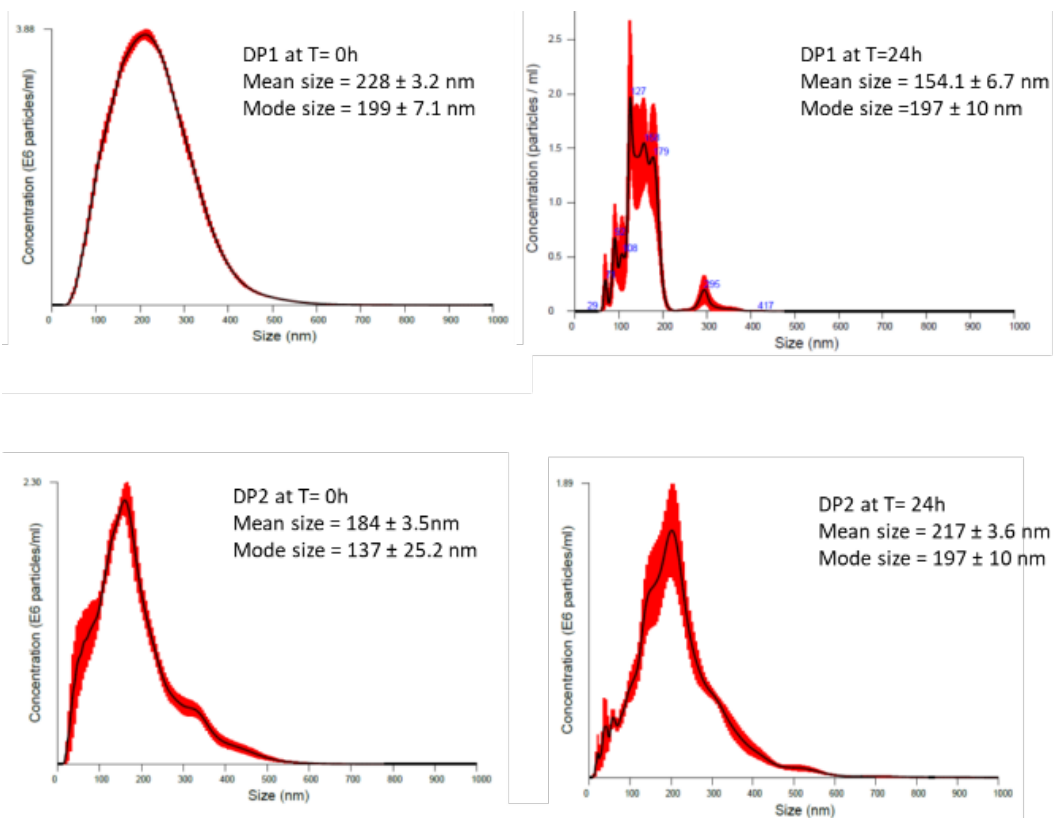
Figure 1. Particle size distribution obtained by (NTA) of TiO 2 NPs using the two proposed dispersion procedures (DP1 and DP2) in culture medium at 0 and 24 h. The black line is the mean distribution and the red filling represent standard errors between captured videos.